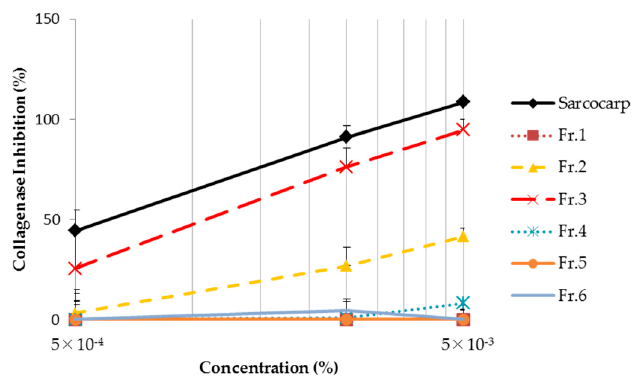
Figure 5. Collagenase inhibition effect of the fractions obtained from the extract of C. sinensis sarcocarp. The sarcocarp extract and fractions were dissolved in distilled water to the appropriate concentration, and the collagenase inhibition was determined. Results are expressed as the mean ± SD (n = 3). The sample concentration is described as the sarcocarp equivalent, calculated by the response rate in each fraction.